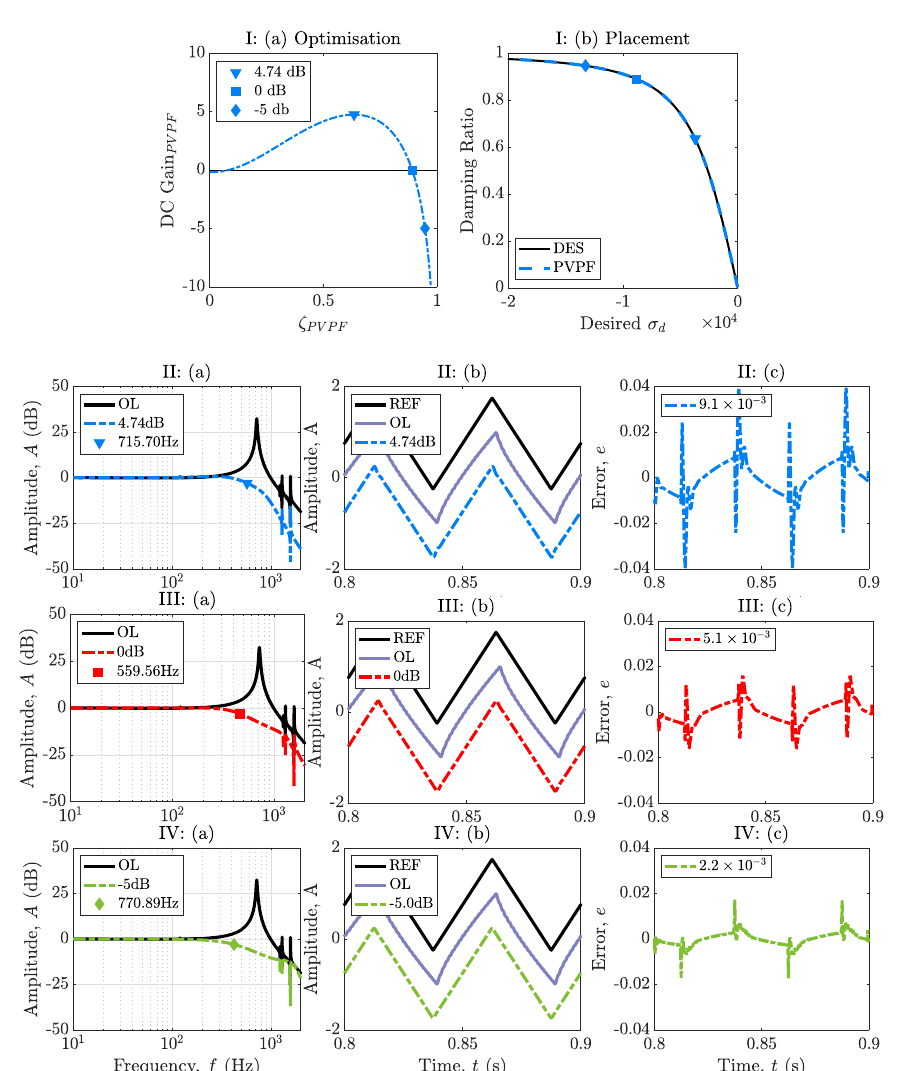
Figure 4. The PVPF optimisation curve ( I ): ( a ) shows how for a determined system of equations, only singular solutions exist for a single damping ratio. Simulation set ( I ) shows the DC gain vs. closed–loop damping ratio and pole–placement in PVPF control. Simulation sets ( II – IV ) correspond to the closed–loop damping values of ζ PVPF = [ 0.63,0.891,0.947 ] , respectively, and then at each point, the PVPF–controlled system is put in a closed–loop with an integral tracker. For each set of simulations, the damped and tracked bode plot, triangle wave time history and error plots are considered for each possible plot on the solid and dashed sections of the optimisation curve. I : ( a , b ) represent the PVPF optimisation curve and the desired and VPF pole–placement curves respectively. Key points are marked on I : ( a ) at DC Gain PVPF = [ 4.74,0, 5 ] . Sub figures ( II – IV ): ( a – c ) consist of − each Bode responses, time histories and error plots respectively. II : ( a – c ) correspond to simulations taken at a DC gain of 4.74dB, with III : ( a – c ) at a DC gain of 0dB and IV : ( a – c ) at aDC gain of 5dB, − respectively. As before, an integral tracker is fitted to each controller highlighted in I : ( a